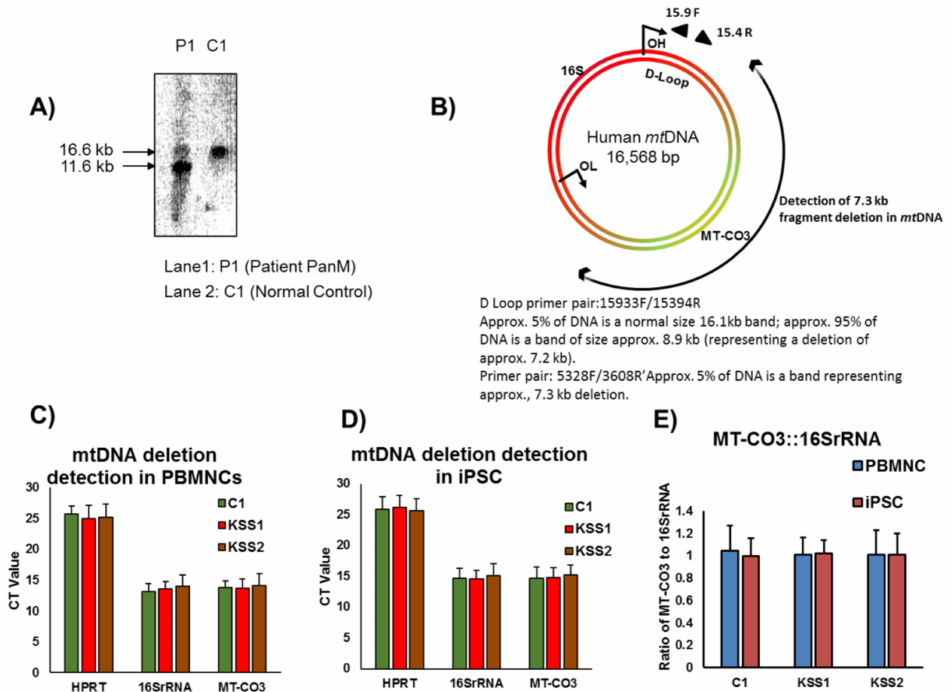
Figure 1. Clinical characterization of patients and PCR analysis of peripheral blood mononuclear cells (PBMNC) and induced pluripotent stem cells (iPSC). ( A ) Clinical report of Kearns Sayre syndrome (KSS) patient labelled as KSS1. Southern blotting of mitochondrial DNA (mtDNA) from muscle biopsy denotes a ~5 kb deletion leading to two bands. ( B ) Clinical diagnosis report of the patient labelled as KSS2 denotes a deletion of ~7.3 kb in the mtDNA from the muscle biopsy. ( C , D ) mtDNA deletion detection was conducted by carrying out PCR reaction using a set of 3 primers specific to regions in-genetic DNA (Hypoxanthine Phosphoribosyltransferase 1 ( HPRT) ), possible deletion site on mtDNA (Mitochondrial complex III ( MT-CO3) ) and non-affected site on mtDNA (16S Ribosomal RNA ( 16S rRNA) ). No deletion was observed in either the PBMNC ( C ) or, respectively, derived iPSC ( D ). The deletions if present would have been denoted by increase in the Ct value for MT-CO3 gene. ( E ) Ratio of the Ct values of the MT-CO3 to the Ct values of 16S rRNA were calculated for the control, KSS1 and KSS2 samples (PBMNC and iPSC). The ratios denote absence of any mtDNA deletion in the samples. n = 3, each experiment (in panels C, D and E) was repeated 3